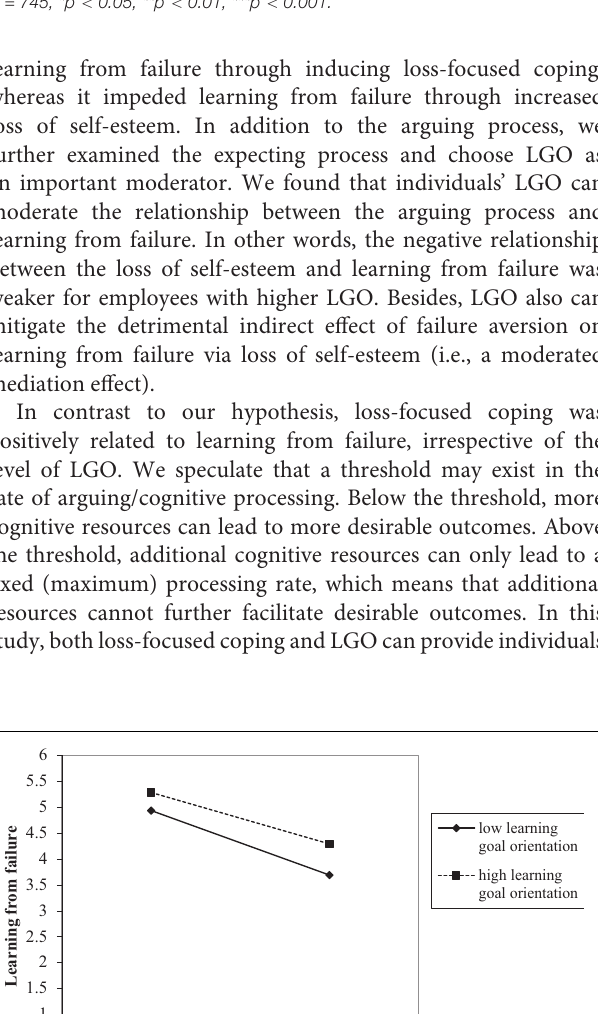
Model 1: Mediation